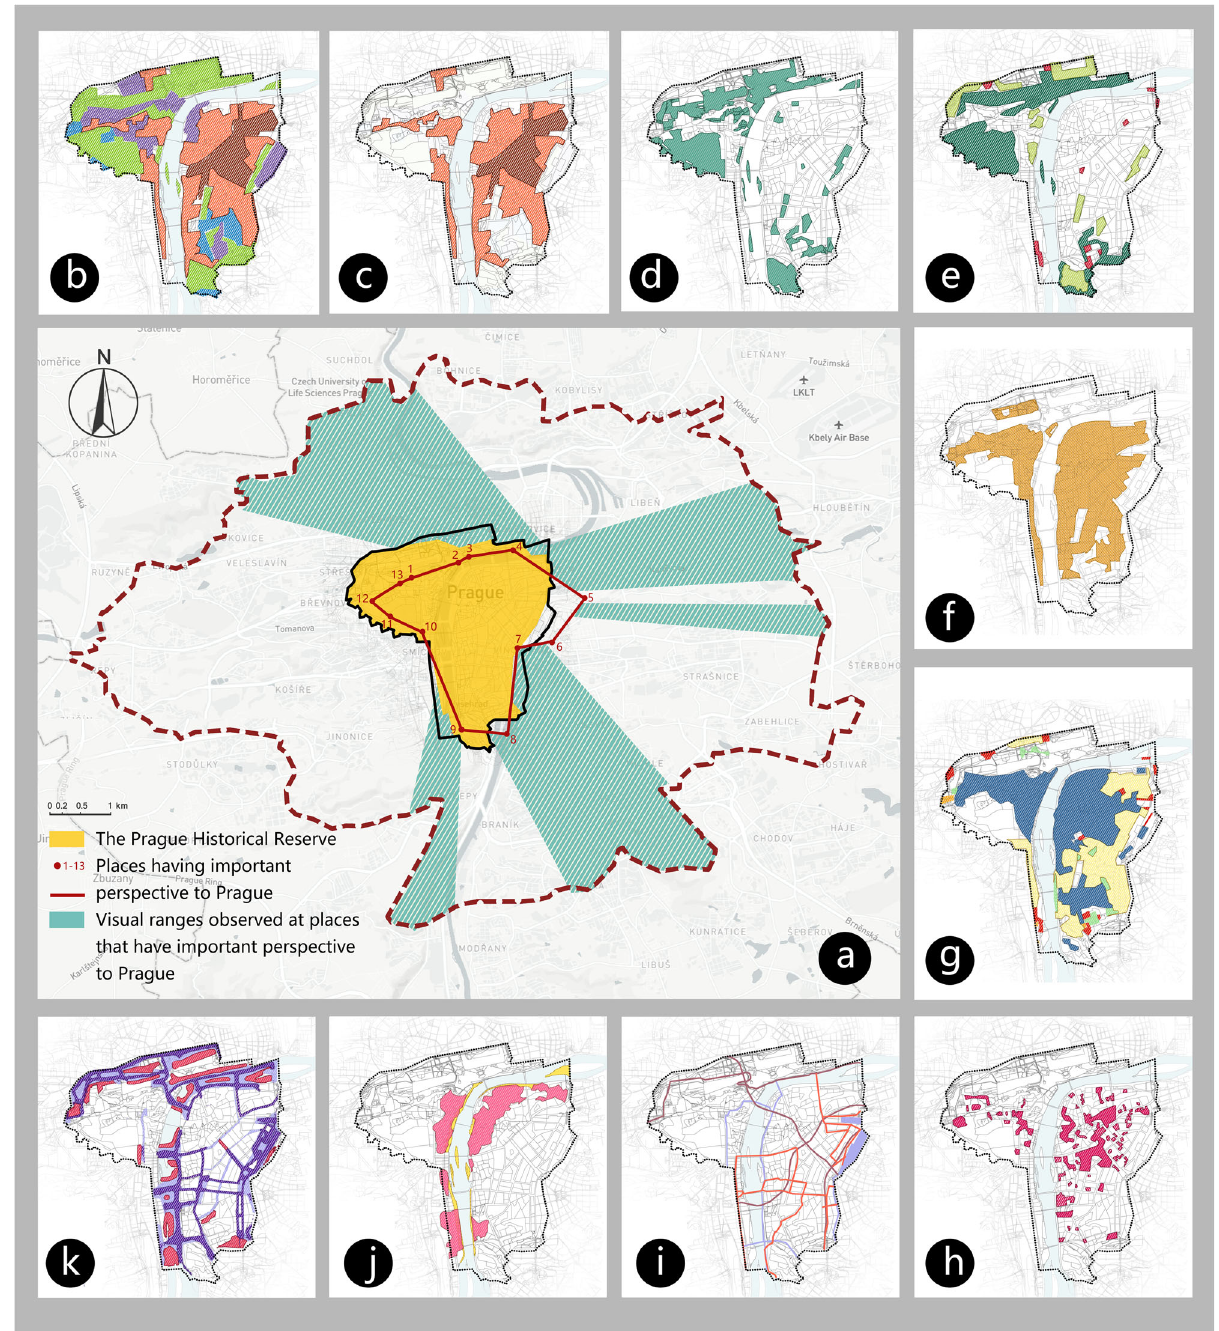
Fig. 3 Urban planning for the Prague Historical Reserve and the Cultural Heritage. The buffer zone ( a ), residency areas ( b ), functional utilization areas ( c ), green areas ( d ), regulation of space ( e ), landscape of roofs ( f ), variety of planning ( g ), underground protected areas ( h ), traf fi c planning ( i ), air pollution areas ( j ), fl ood marks and fl ood areas ( k ). Adopted from (Beránková,